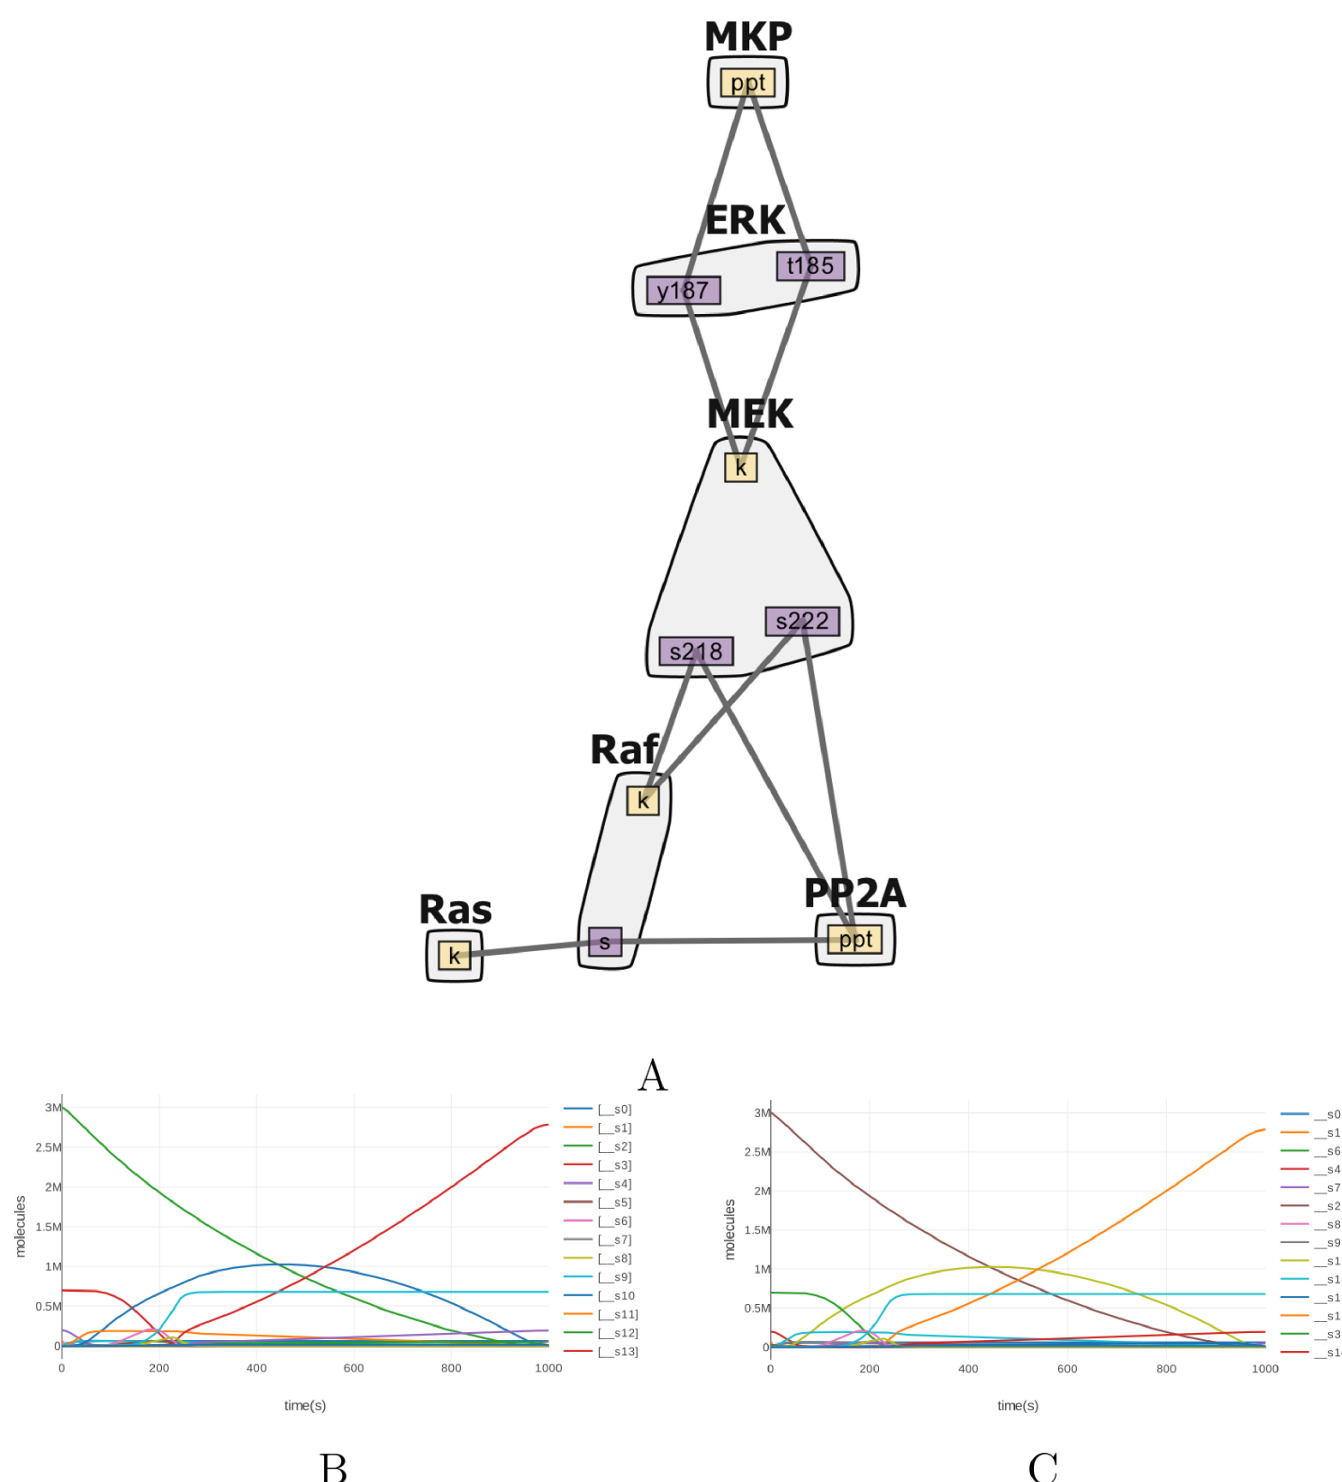
Fig 11. A rule–based MAP kinase model [53, 54] and its corresponding block configuration produced by the cytomorphic compiler. (A) A contact map for the kinase cascade generated using RuleBender [55]. The contact map shows the molecular species present in the model—Ras, Raf, MAPK/ERK Kinase (MEK), extracellular signal-regulated kinase (ERK), MAP kinase phosphatase (MKP), and Protein phosphatase 2 (PP2A). When expanded to an SBML mass–action network representation, this rule–based model expands into a network with 20 reactions and 21 distinct dynamical states. An SBML simulation of the flattened rule–based model (B) and a block simulation (C) are identical up to 3 significant figures (simulated using libRoadRunner, CVODES solver, absolute and relative tolerances 10 − 20 and 10 − 12 respectively).